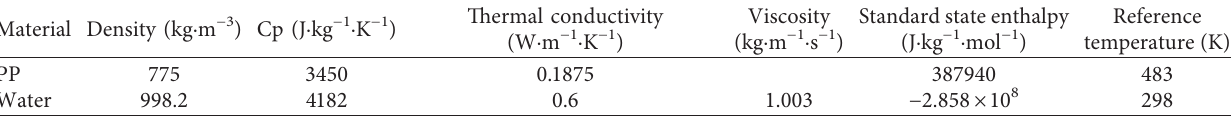
Table 3: Physical properties of melt and water in the